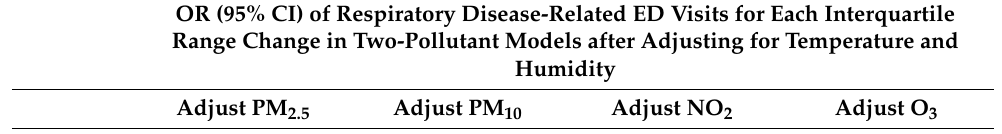
Table 4. OR (95% CI) of respiratory diseases ED visits for each interquartile range change in two- pollutant models.